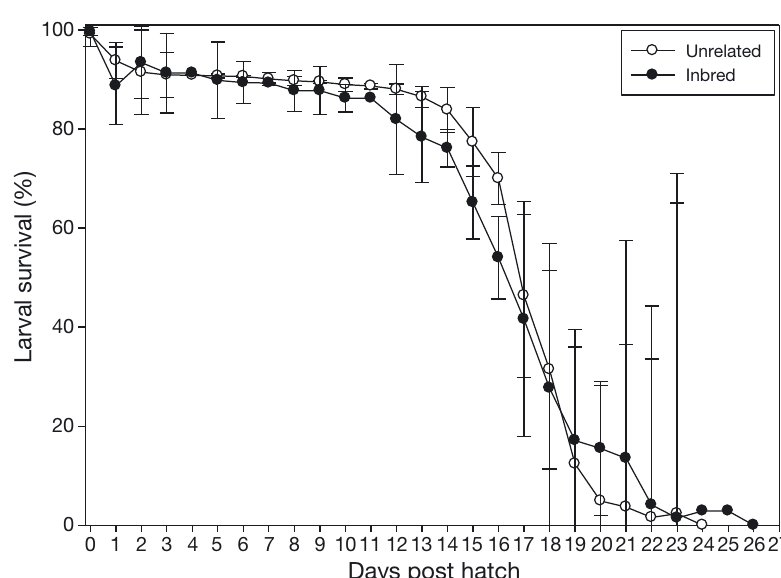
Fig. 6. Gadus morhua . Mean (±SD) cumulative larval survival (%) of offspring from inbred (filled circles) and unrelated (open circles) crosses of Atlantic cod after